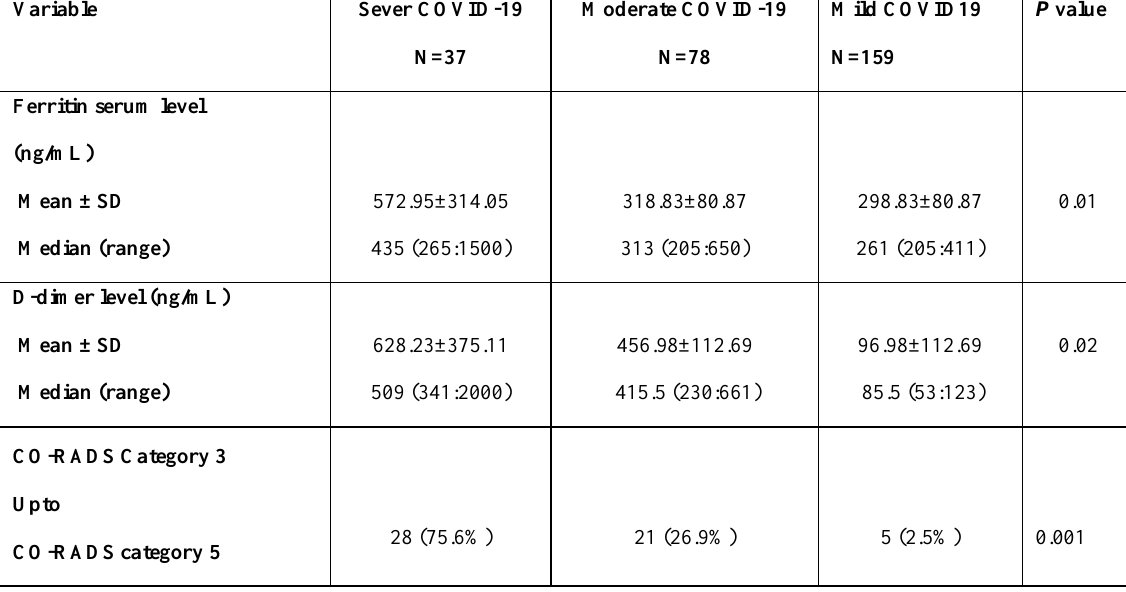
Table 1. Radiological, clinical features of sever COVID-19 patients versus patients with moderate disease. Variable